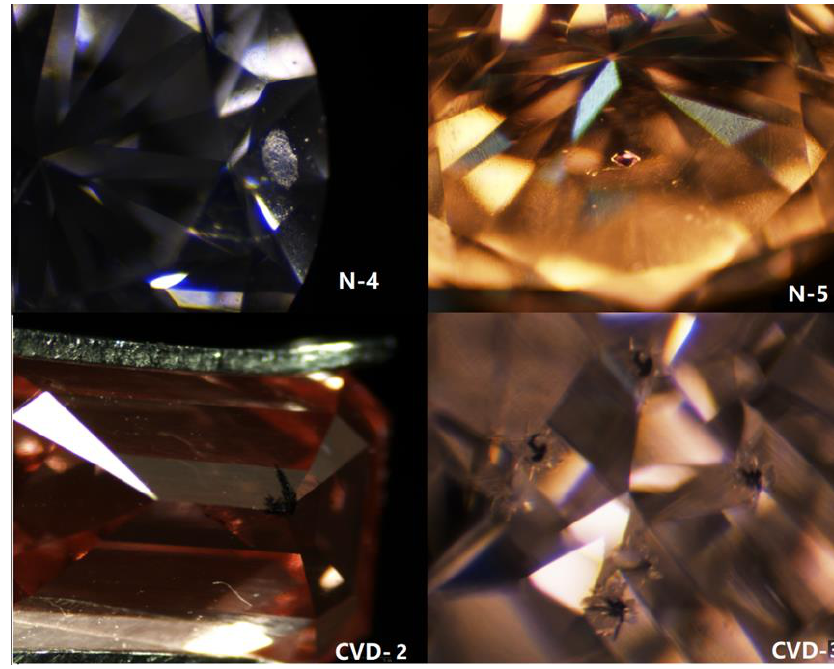
Figure 2. Different inclusions in CVD synthetic and natural diamond samples. Abnormal birefringence and random direction of interference color in natural dia- monds can be observed under a polarizing microscope. However, CVD synthetic diamonds form stress lines with high-order interference color and obvious abnormal birefringence due to their short growth time [20]. This phenomenon can be observed with a polarizing microscope. All the CVD synthetic diamonds have grainy patchy birefringence patterns, which can be distinguished from natural diamonds. Compared to CVD samples in Figure 3, high color grade (E–F) of CVD-1, CVD-2, and CVD-3 has less abnormal birefringence and low interference color, while low color grade (I–K) of CVD-6, CVD-7, and CVD-8 has high abnormal birefringence and high order interference color. It can be inferred that internal defects and stress lines of diamonds influence their color grades. These grainy birefringence patterns, if clearly seen, are a very reliable criterion of recognition of CVD diamonds. Com- pared with CVD synthetic diamonds, natural diamonds have less abnormal birefringence and low interference color under the same magnification (Figure 3). CVD synthetic dia- monds with the same color grade have more apparent abnormal birefringence than natural diamond samples and also have higher-order interference color than natural diamonds. This is helpful for distinguishing between CVD synthetic dia- monds and natural diamonds.